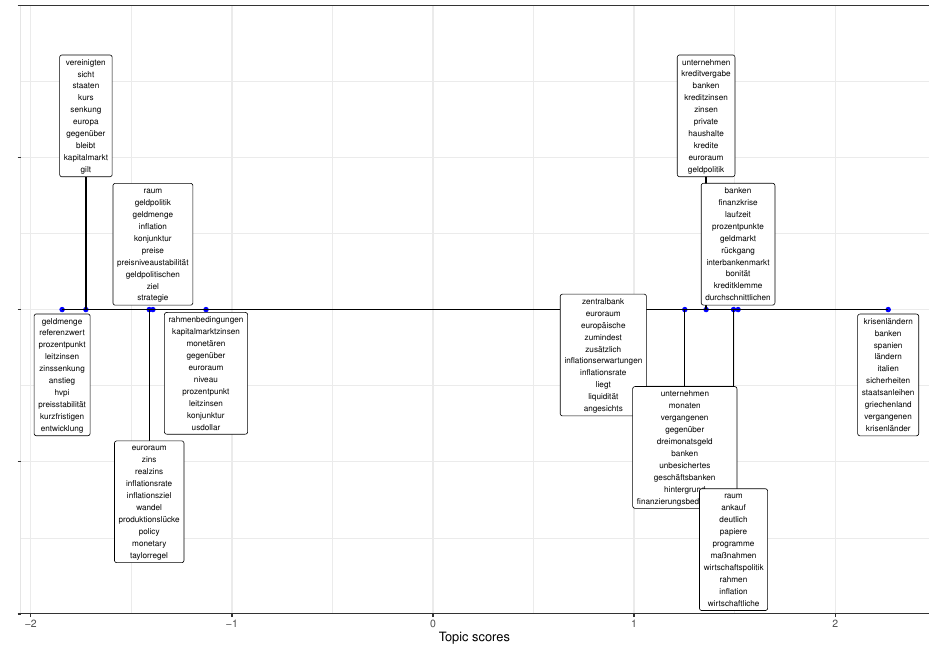
Figure 11. Topic Scores learned via Topic Scaling (11 topics). Table 5. Top 10 words from the estimated Topic Scaling with 11